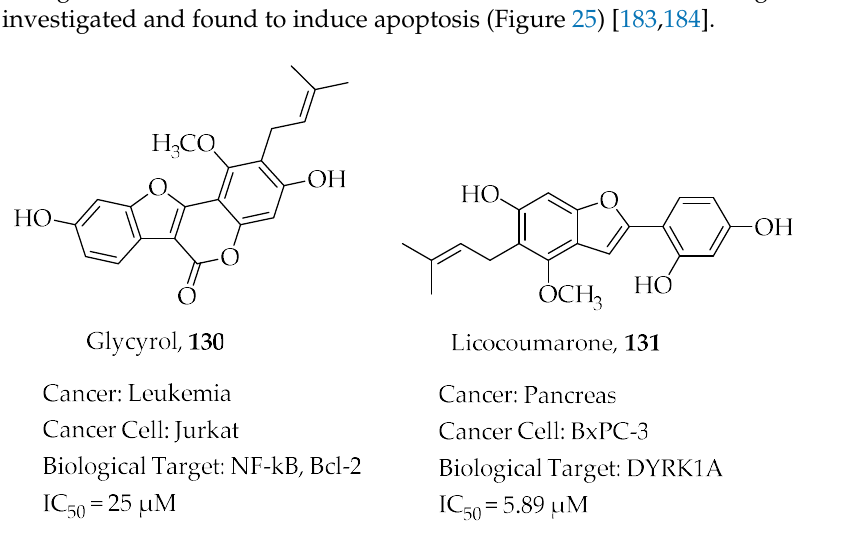
Figure 24. Structure of the prenylated isoflavonoid Licoricidin with a summary of its biological ac- tivity towards selected cancer targets.